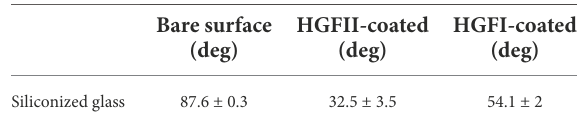
TABLE 1 The water contact angle of HGFII modified siliconized glass compared with HGFI. a